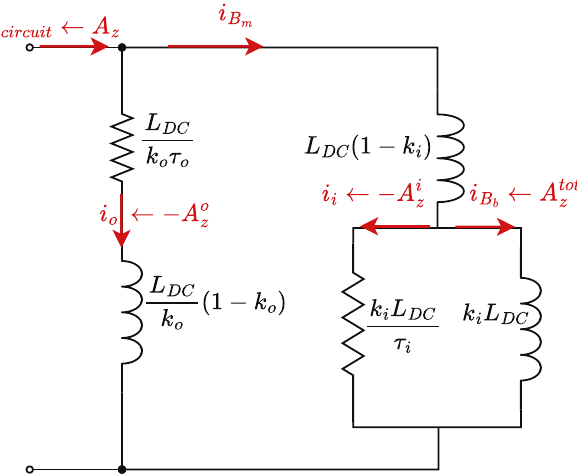
Figure 2: Full circuit model for a lossy superconducting magnet: inner and outer conducting